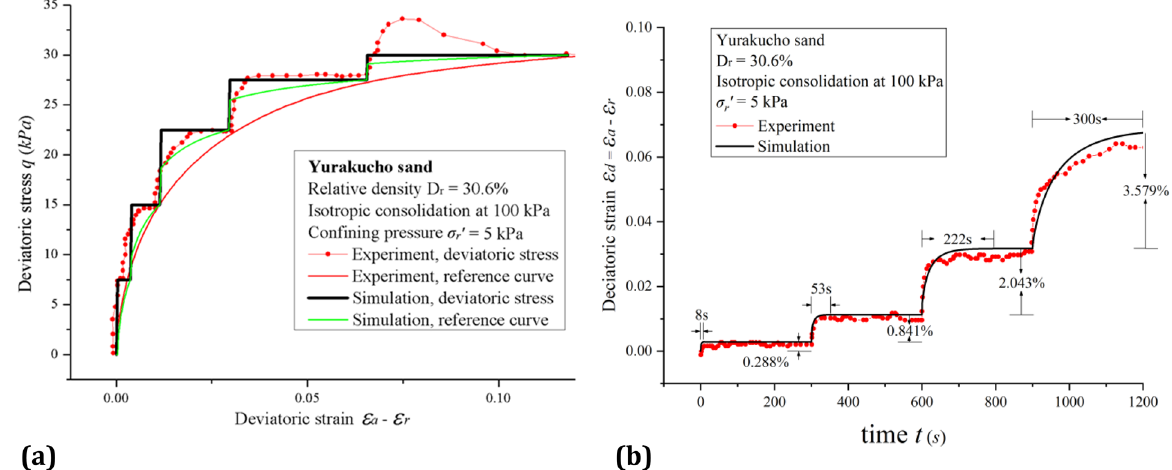
Figure 3. Experimental and simulation results of triaxial compression experiments on Yurakucho sand (( a ) Simulation of deviatoric stress–strain curve; ( b ) Simulation of time-deviatoric strain curve with loading interval of 300